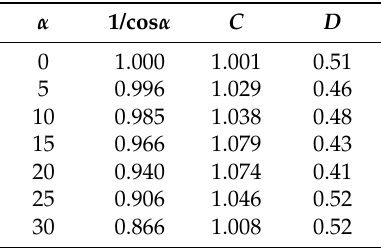
Table 1. Coefficients table under different inclination angles.